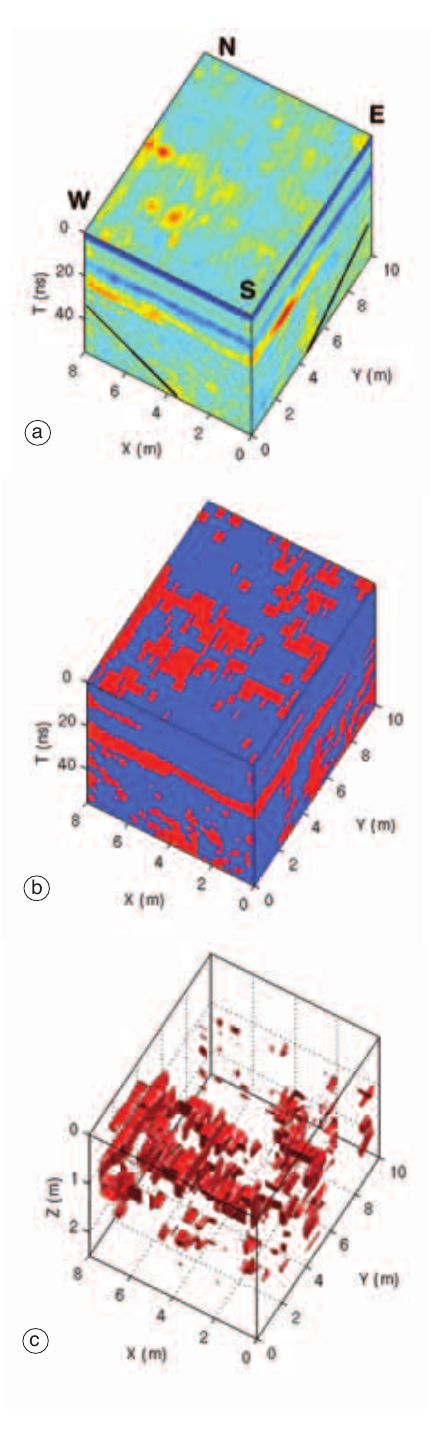
Fig. 10a-c. Zone B. 3D visualization by means of a procedure consisting of: complex attribute extraction, thresholding and 3D rendering. Envelope stack on top and lateral sides (a), thresholding (b) and 3D render- ing